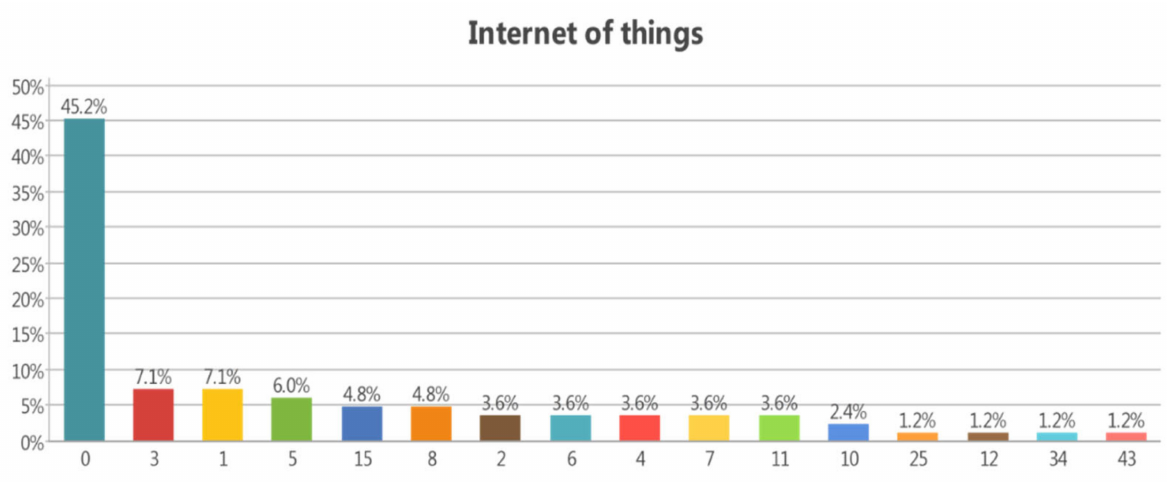
Figure 7. Significant and insignificant keywords being used in the